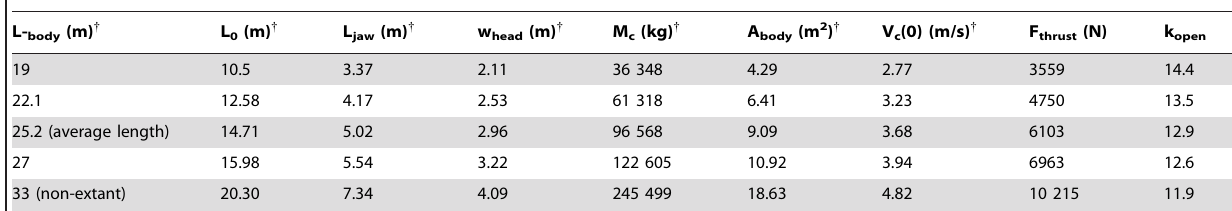
Table 1. BLF3 simulation inputs – blue whales.